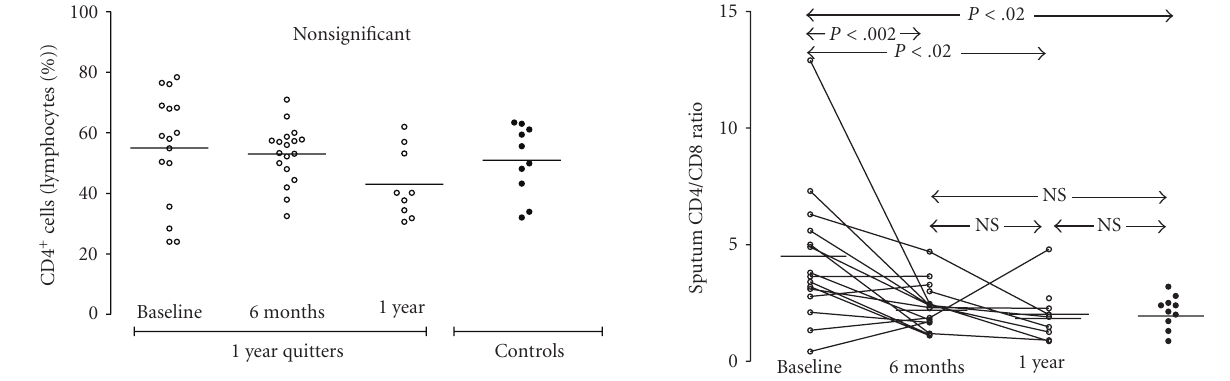
Figure 3: Percentage of sputum CD4 + T-cells (% sputum lympho- cytes) in “healthy” smokers before smoking cessation ( n = 16), after 6 months of smoking cessation ( n = 18), and after 1 year of smoking cessation ( n = 9). Results from 10 never-smokers (controls) are also presented.